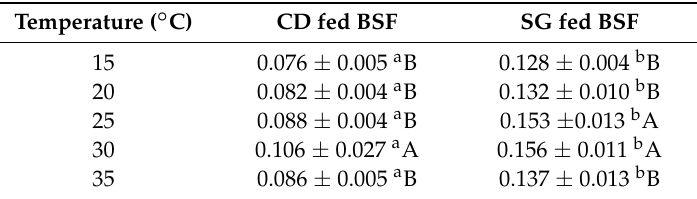
Table 2. Mean ( ± SD) prepupal weight (in grams) of black soldier fly reared on two different organic substrates at five different temperature